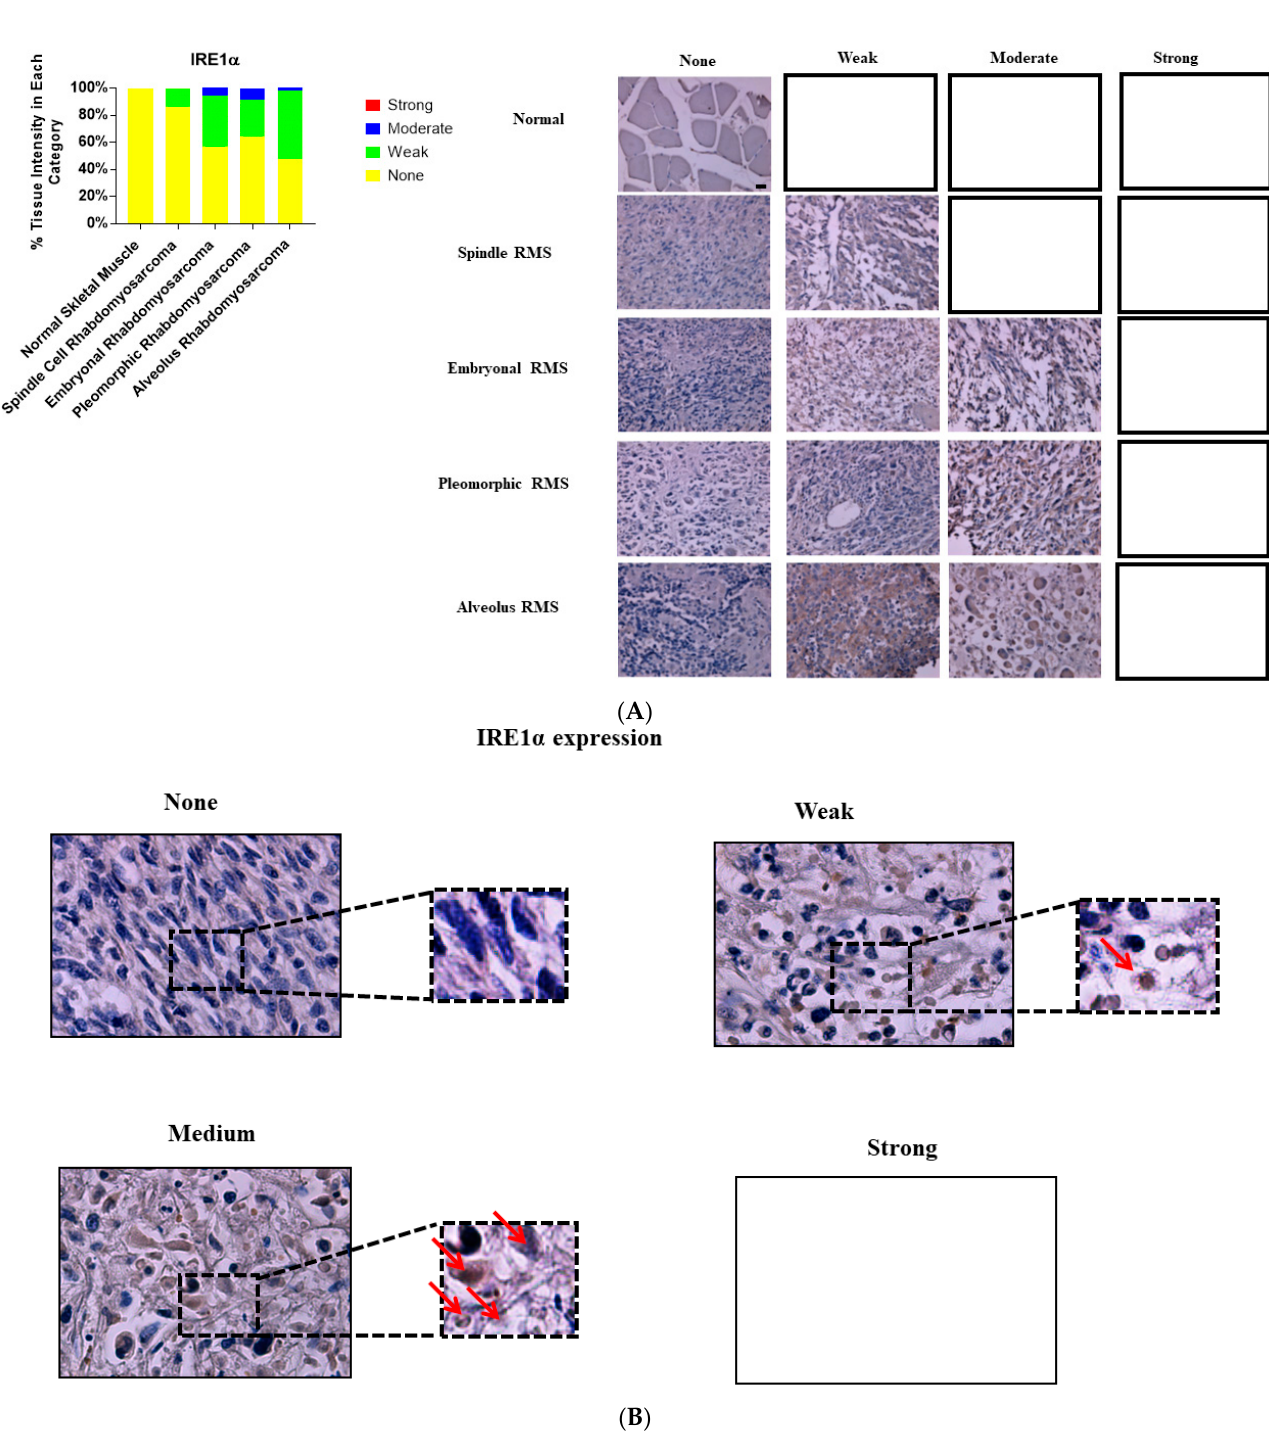
Figure 2. Immunohistochemical staining for IRE1 α in human skeletal muscle and RMS tissue. ( A , B ). We detected IRE1 α expression (red arrows) in a human RMS TMA; details on the TMA were mentioned in the Materials and Methods section. Three independent pathologists blindly evaluated the immunohistochemical IRE1 α expression (None = no staining; W: Weak staining; M: Moderate staining; S: Strong staining); the empty slots indicate that no samples met the characteristics of that specific group. Our results show that IRE1 α is associated with RMS (Table 1). The results also show that IRE1 α expression is associated with ARMS, ERMS, PRMS, SRMS (Table 3). The scale bar refers to 50 µM.